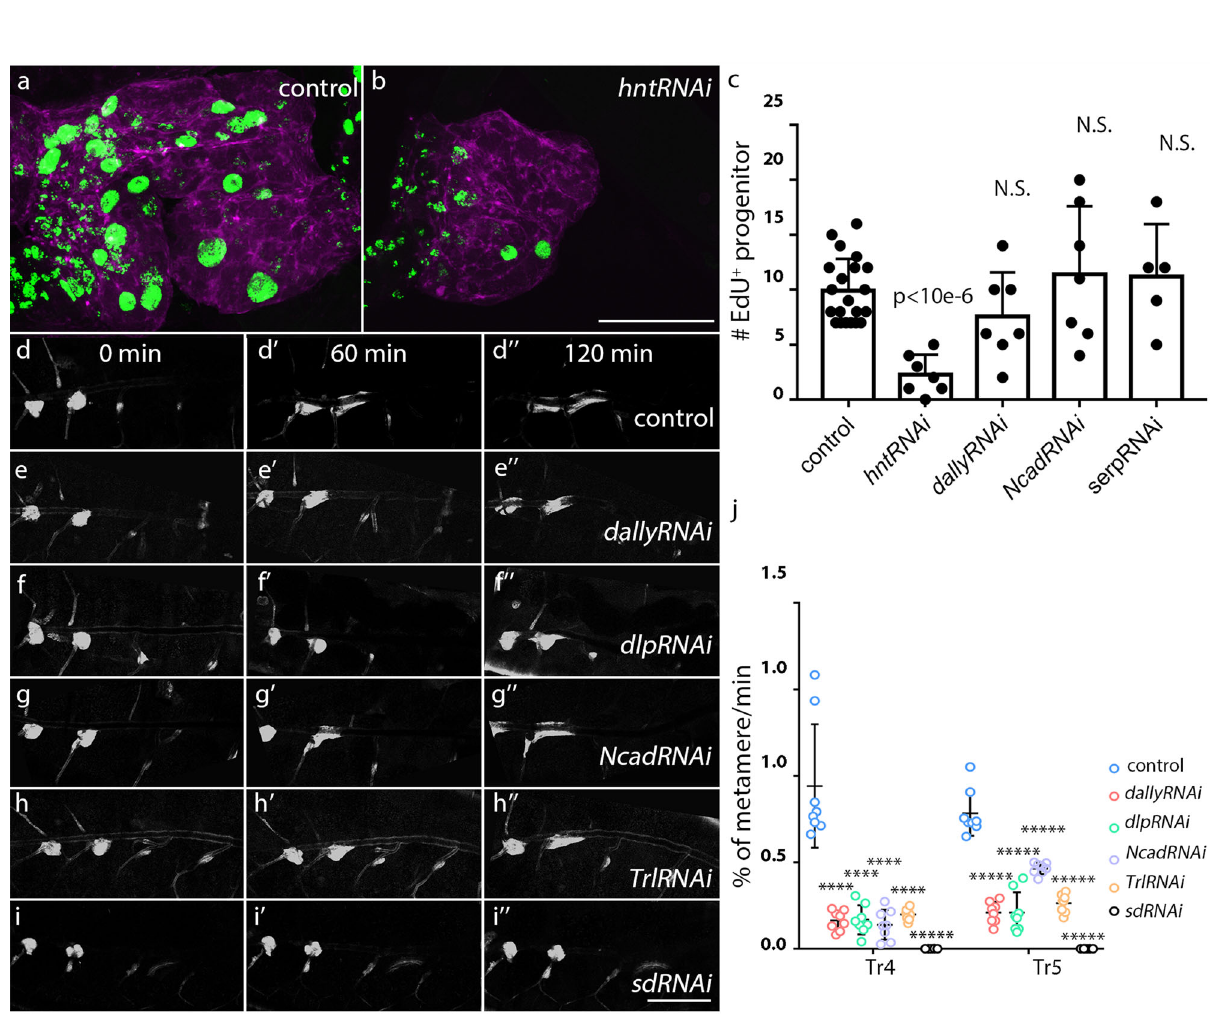
Fig. 8 The targets of Yki regulate the proliferation and migration of tracheal progenitors. a – c The proliferation of tracheal progenitors requires Hnt. The incorporation of EdU in the tracheal progenitors of control ( a ) and hntRNAi ( b ). c Bar graph plots the number of EdU incorporation in control ( n = 21), hntRNAi ( n = 7; p = 7.39e-7), dallyRNAi ( n = 7; p = 0.106), NcadRNAi ( n = 7; p = 0.380), serpRNAi ( n = 5; p = 0.437). Three biologically independent experiments were performed. N.S. not signi fi cant. d – i ” Dependence of tracheal progenitor migration on Dally ( d – d ” ), Dlp ( e – e ” ), Ncad ( g – g ” ), Trl ( h – h ” ) and Sd ( i – i ” ). Confocal images showing the localization of tracheal progenitors at 0 h APF ( d , e , f , g , h , i ), 1 h APF ( d ’ , e ’ , f ’ , g ’ , h ’ , i ’ ) and 2 h APF ( d ” , e ” , f ” , g ” , h ” , i ” ). j Scatter plot showing the velocity of migrating progenitors. Eight biologically independent experiments were performed. n = 8 for each genotype. Tr4: dallyRNAi ( p = 2.77e-5), dlpRNAi ( p = 3.38e-5), NcadRNAi ( p = 2.38e-5), TrlRNAi ( p = 4.09e-5) and sdRNAi ( p = 3.02e-6); Tr5: dallyRNAi ( p = 2.05e-8), dlpRNAi ( p = 2.39e-7), NcadRNAi ( p = 9.76e-6), TrlRNAi ( p = 5.32e-8) and sdRNAi ( p = 9.47e-11). c , j Results are presented as mean values ± SD. Unpaired two-tailed t -test was used for all statistical analyses. No adjustments were made for multiple comparisons. Scale bars: 30 μ m ( a , b ) and 300 μ m ( d – i ” ). Genotypes: ( a ) btl-Gal4/ + ; P[B123]-RFP-moe/tub-Gal80 ts ; ( b ) btl-Gal4/UAS-hntRNAi; P[B123]-RFP-moe/tub-Gal80 ts ; ( d – d ” ) btl-Gal4/ + ; P[B123]-RFP-moe/ + ; ( e – e ” ) btl-Gal4/ + ; P[B123]-RFP-moe/UAS-dallyRNAi ; ( f – f ” ) btl-Gal4/ + ; P[B123]-RFP-moe/UAS-dlpRNAi ; ( g – g ” ) btl-Gal4/ + ; P[B123]- RFP-moe/UAS-NcadRNAi ; ( h – h ” ) btl-Gal4/UAS-TrlRNAi; P[B123]-RFP-moe/ + . ( i – i ” ) btl-Gal4/ + ; P[B123]-RFP-moe/UAS-sdRNAi . Source data for ( c , j ) are provided as a Source Data fi